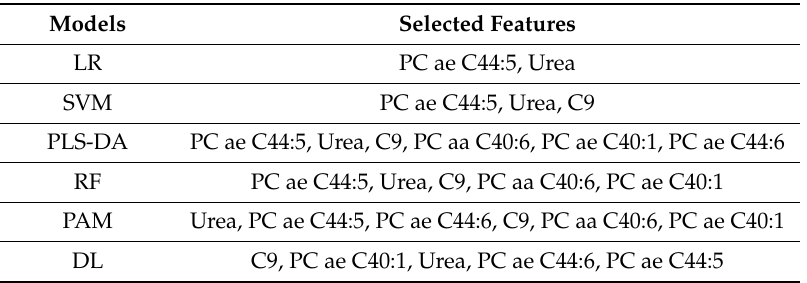
Table 2. List of panels of metabolites used in different artificial intelligence methods. LR: logistic regression; SVM: support vector machine; PLS-DA: partial least square-discriminant analysis, RF: random forest; PAM: prediction analysis for microarrays; DL: deep learning.